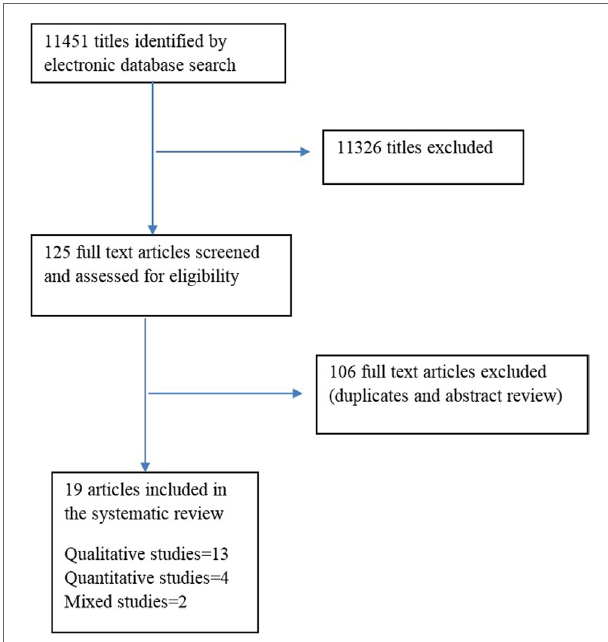
FigURe 1 | Flow chart of Hiv disclosure systematic review search process